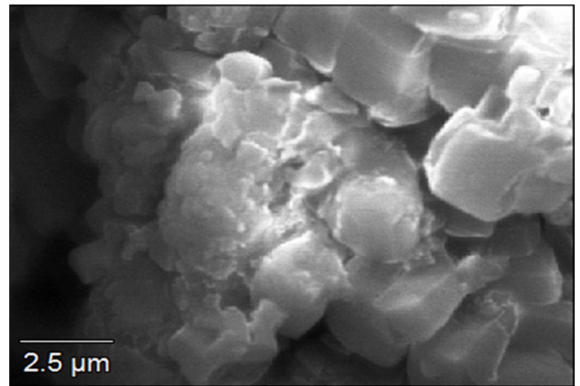
Figure 1. Surface morphology of the bioflocculant.